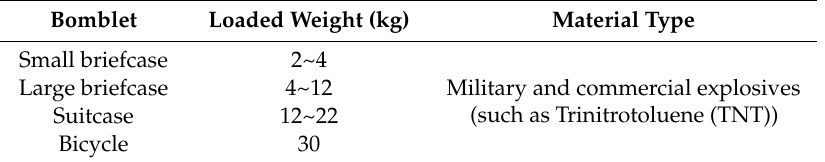
Table 1. The typical weight of explosive materials [12].